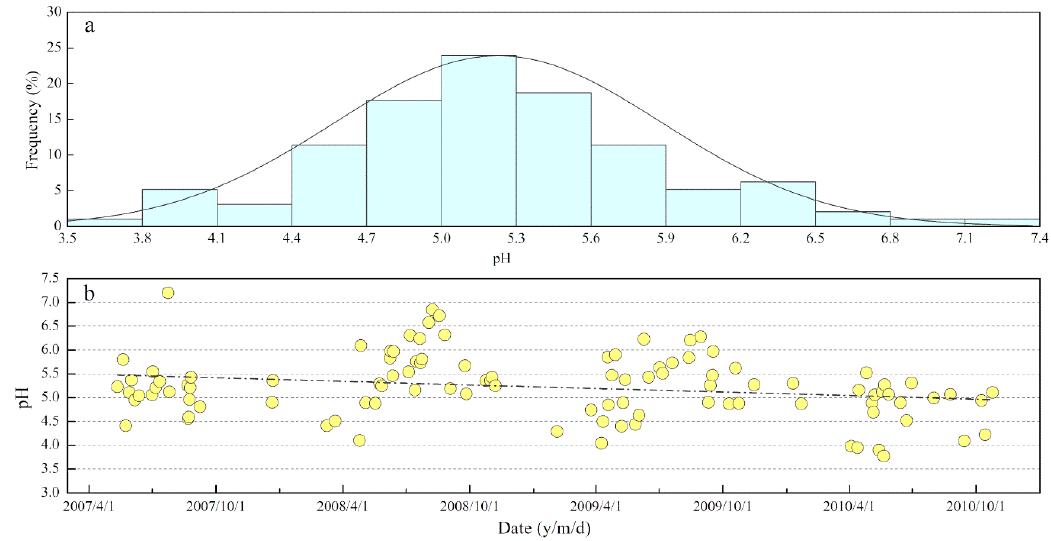
Figure 3. The pH values of rainwater ( a ) frequency distribution and ( b ) time series; n = 104.